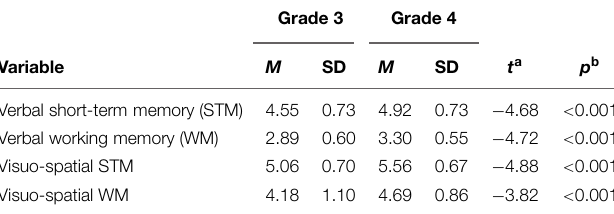
TABLE 1 | Means and SDs of memory